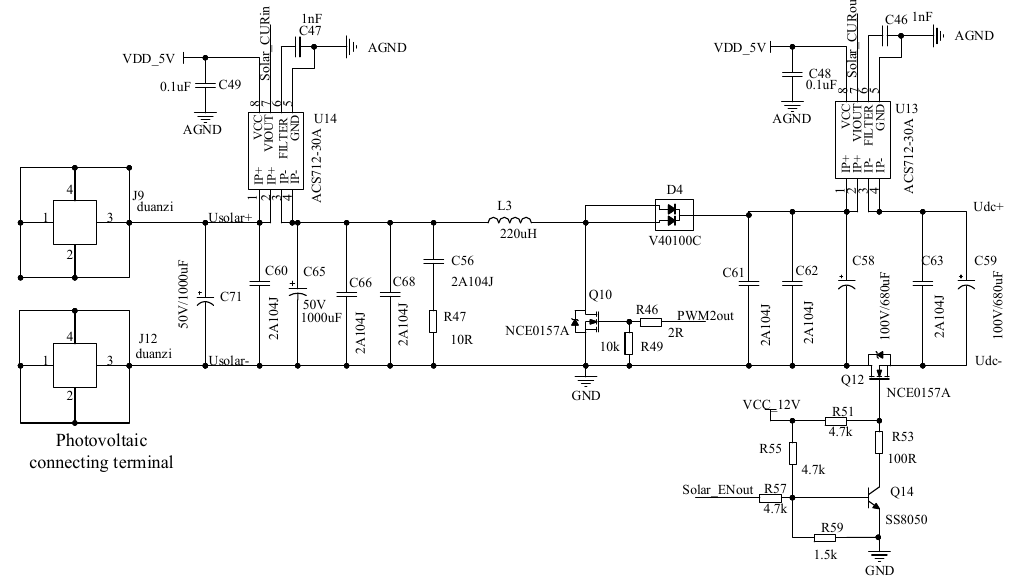
Figure 11. Photovoltaic Power Generation Circuit.